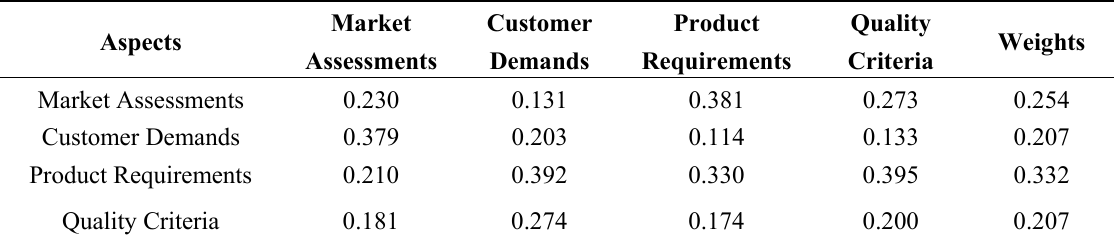
Table 10. Eigenvectors and Consistency Test for